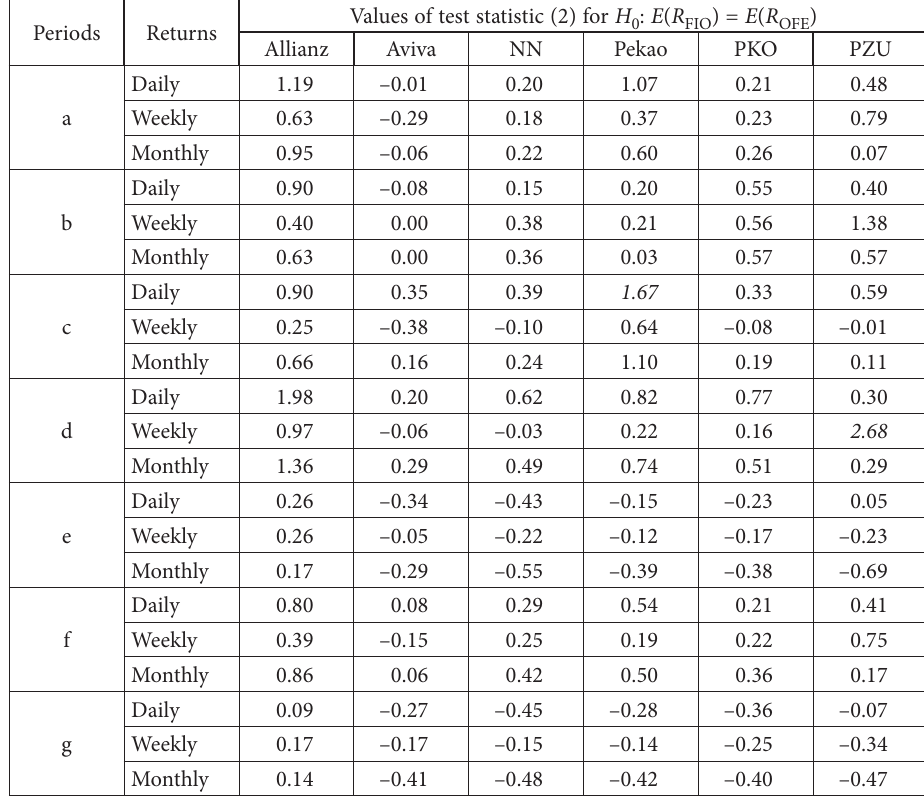
Table 7. Values of statistic (2) for the comparison of expected returns for FIO and OFE (source: own calculations) Periods